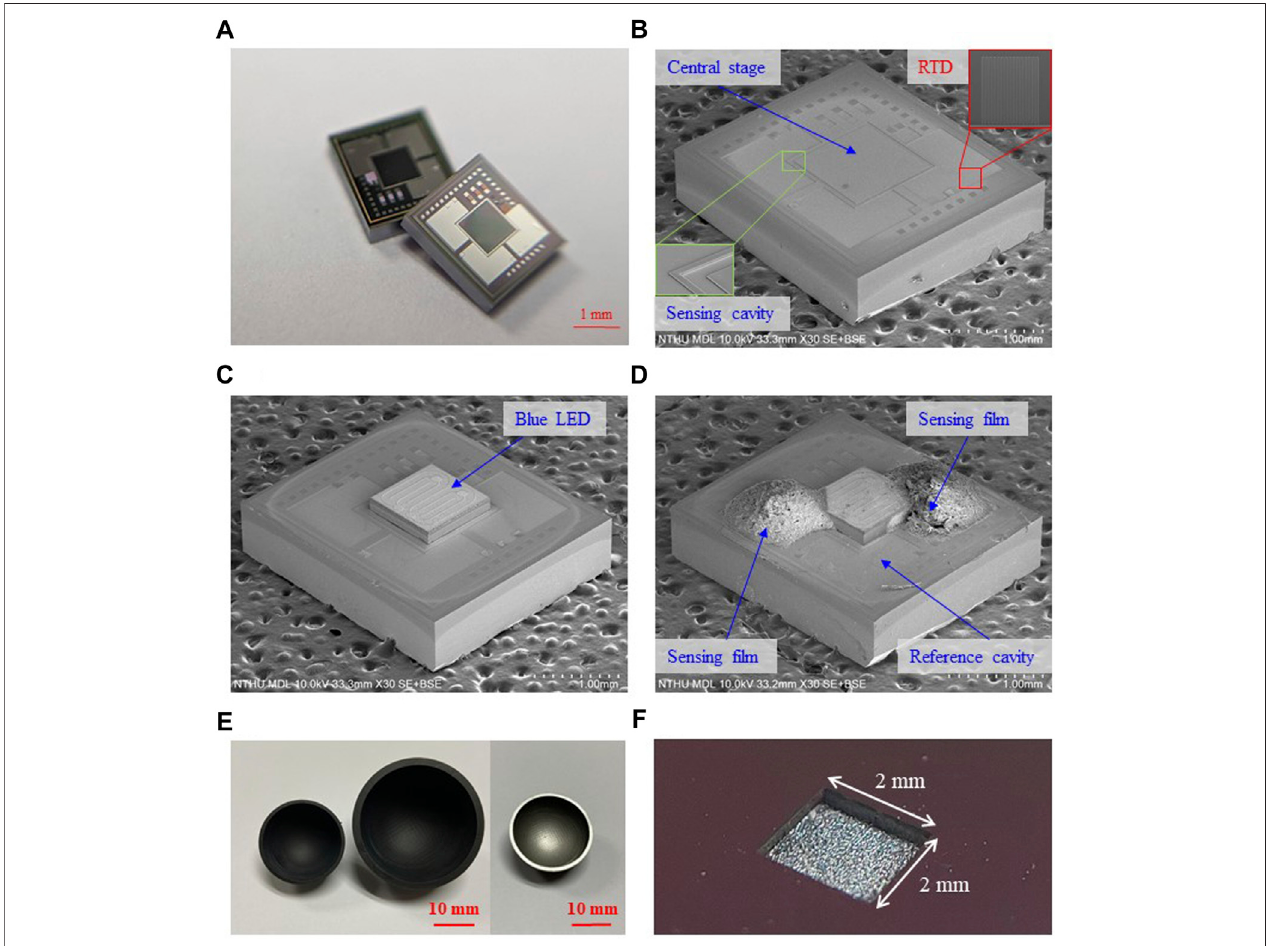
FIGURE 4 | Micrographs to exhibit the typical fabrication and assembly results, (A) the CMOS chip fabricated by the TSMC, (B) the gas sensing chip fabricated after thepost-CMOSprocesses, and theRTD and sensing cavityare shown in theinsetzoom-in SEM micrographs, (C) thegassensing chip bonded with theblue LED, (D) the gassensingchipafter the dispensing ofsensing materials, (E) the3D-printedpolymerhemisphericalshells and after beingcoated withmetal fi lmasthere fl ector, and (F) the micromachined Si fl at plate re fl ector.